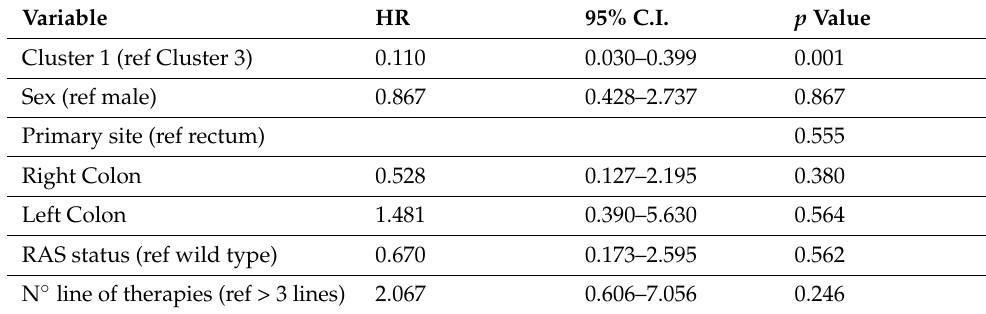
Figure 4. Kaplan-Meier for the PFS of cluster 1 (blue line) and cluster 2 (gold line). A multivariate Cox analysis was performed using clusters (used as dichotomous variables), sex, primary site (left colon, right colon or rectum), RAS mutational status and number of prior therapies as covariates. The belonging in cluster 1 was the only independent factor predicting good PFS, with an HR of 0.110 (95% C.I. 0.030–0.399) (Table 3). Table 3. Multivariate Cox analysis for PFS.